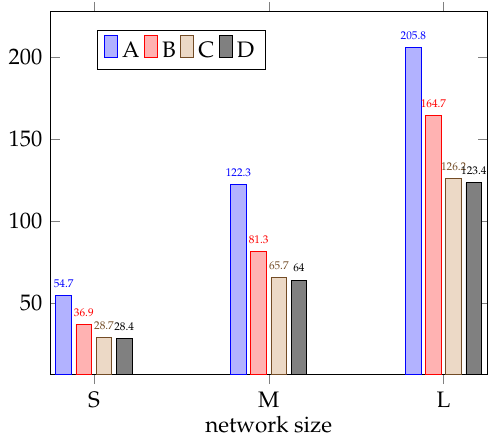
Figure 4. Frame size as a function of the network size.